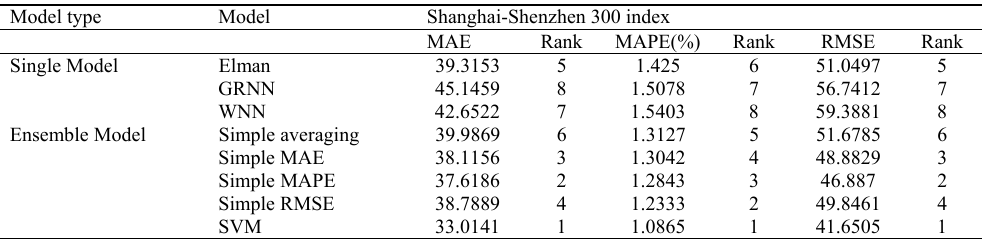
Table 4. Comparison of performance statistics averaging each model over 20 runs in Shanghai-Shenzhen 300